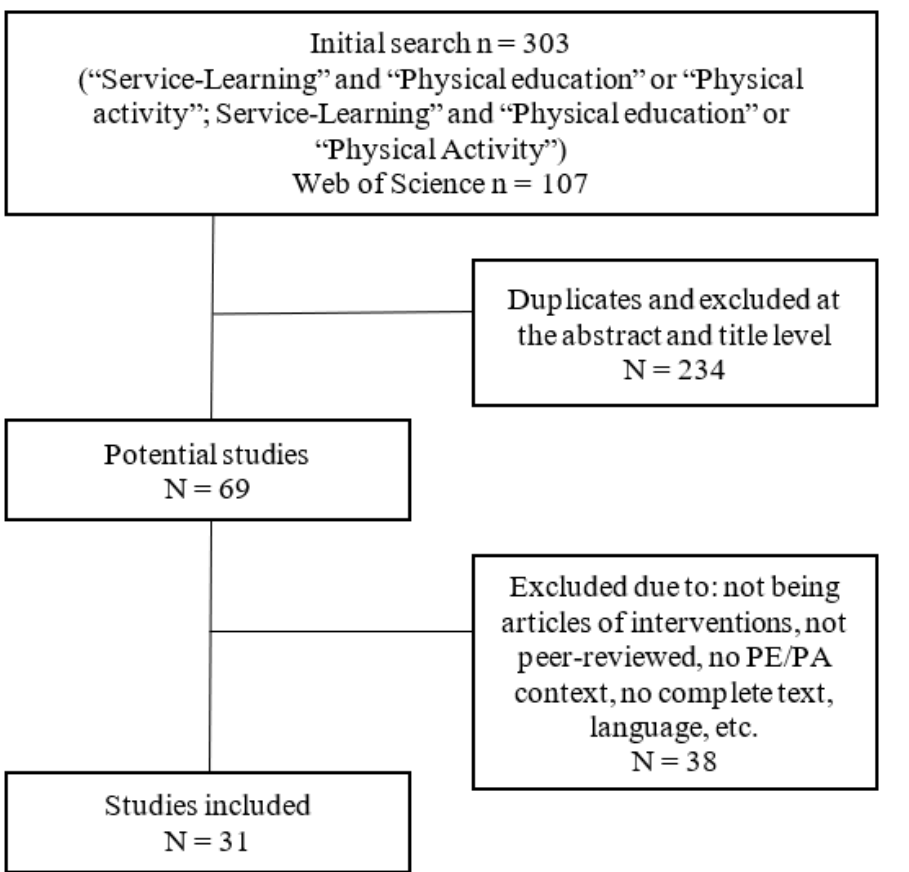
Figure 1. Flow chart of the sampling process.